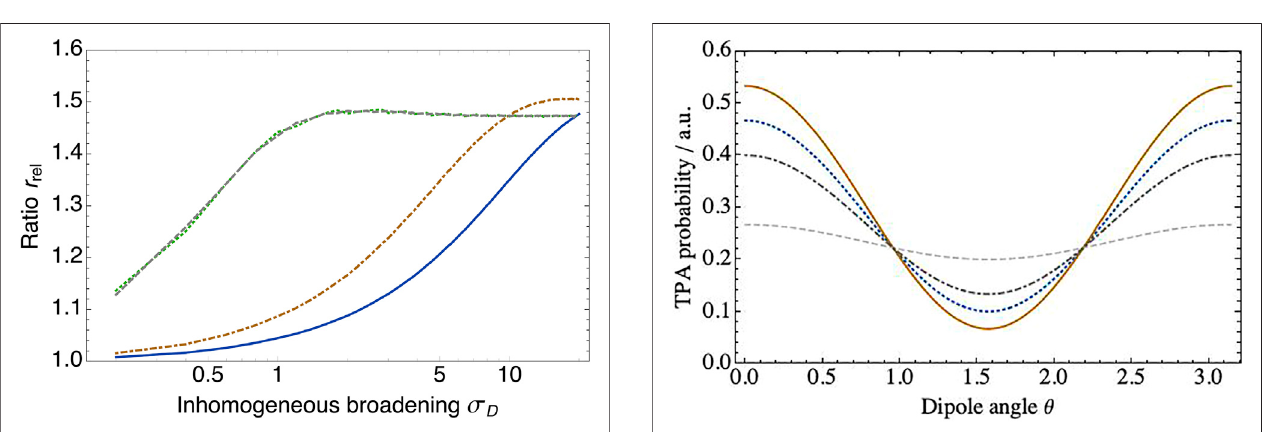
FIGURE 5 | Ratio r rel , Eq. 23 , is plotted vs. the inhomogeneous FIGURE 6 | Polarization dependence of ETPA probability on the angle broadening σ D and entangled states with σ B = 20, σ N = 1 (solid, blue), σ B = 10, between the molecular dipoles according to Eq. 10 . The gray, dashed line σ σ σ σ σ depicts the dependence (24) which is created by the input state (20) . The N = 1 (dot-dashed, red), N = B = 1 (dotted, green), and B = 1, N = 10 (dashed, gray). The intrinsic broadening is fi xed at γ inh = 0.1. black, dot-dashed line is given by Eq. 25 , created by the state (21) . The polarizationdependence (26) ,whichiscreatedbythestate (22) ,isshownasa solid, yellow line for ϕ = 0, and as a blue, dotted line for ϕ = π